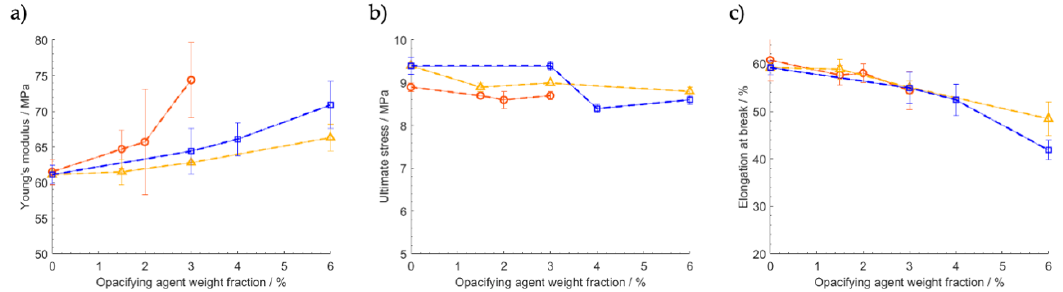
Figure 8. Influence of TiO 2 and MHP content on mechanical properties of LDPE: ( a ) Young’s modulus, ( b ) ultimate stress, and ( c ) elongation at break. Yellow triangles: samples with varying TiO 2 content, blue squares: samples with varying MHP content, orange circles: samples with varying MHP content and fixed TiO 2 content of 1.5 wt.%.